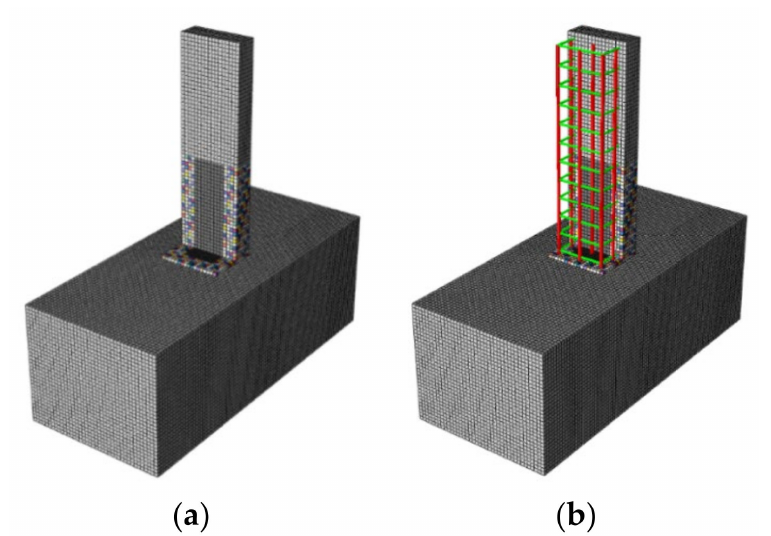
Figure 25. Finite element model of RC pier. ( a ) Analysis model of the pier without bars. ( b ) Analysis model of the pier with